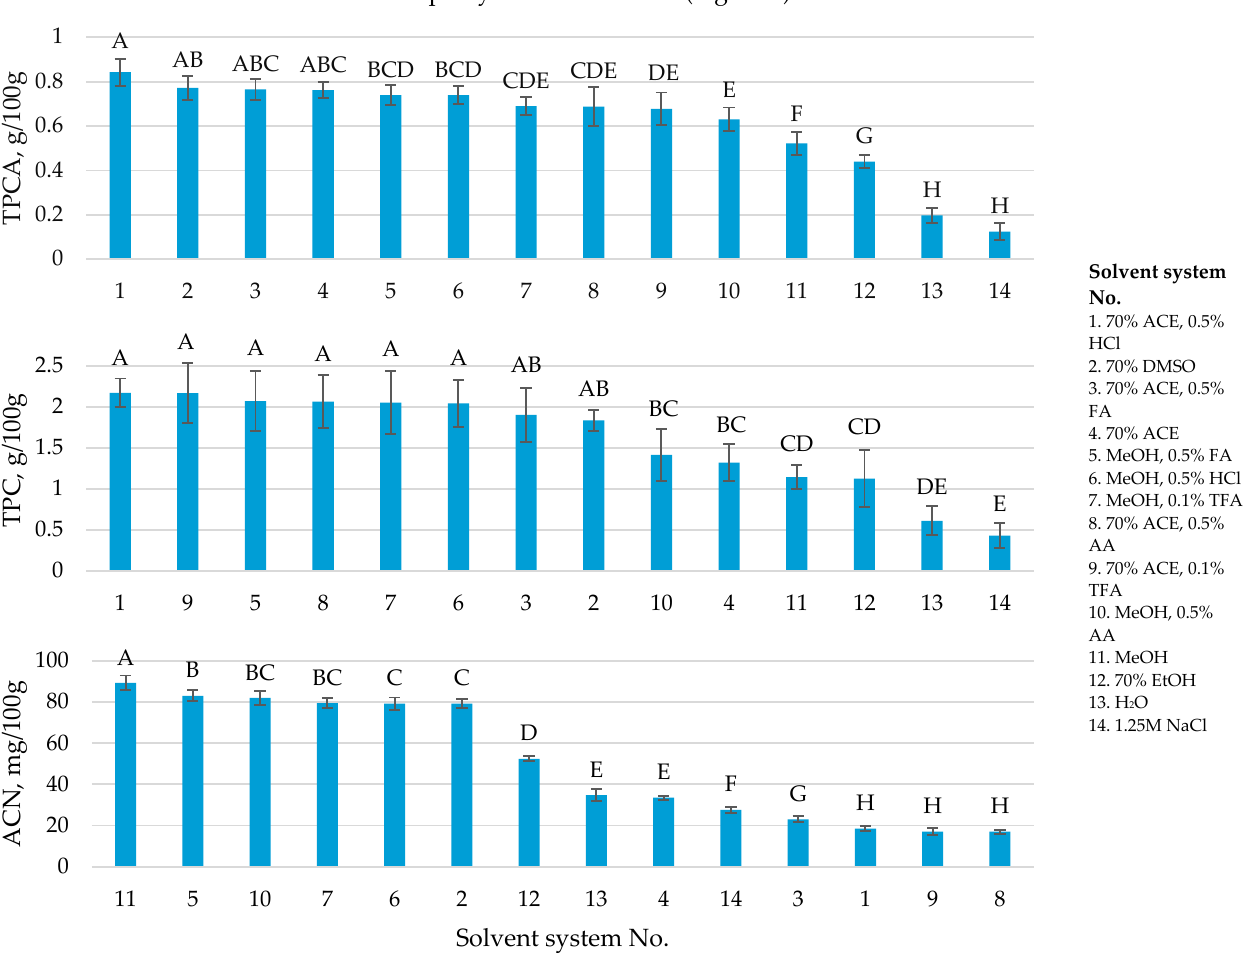
Figure 1. Screening of solvent compositions used for the extraction of procyanidins (TPCA) from American cranberry press residues. Additional measurements of total polyphenolics (TPC) and anthocyanins (ACN) have been conducted. The extractions were performed in triplicate. The means have been compared using ANOVA with post-hoc Tukey’s LSD test. Connecting letters above bars represent statistically different results ( n = 3).